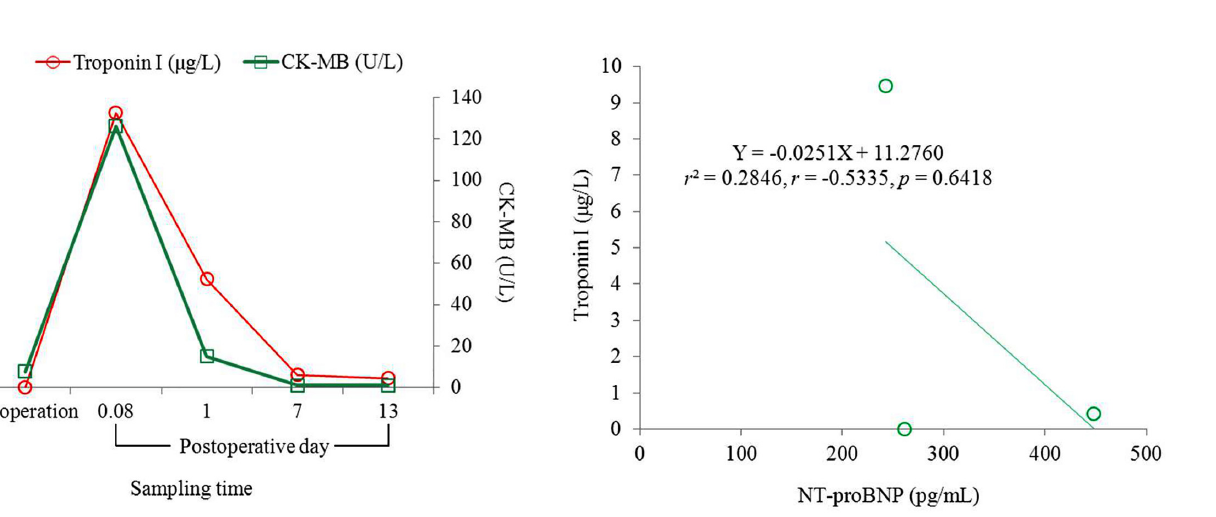
Fig. 1 - A similar changing trend of troponin I and creatine kinase isoenzyme MB. CK-MB=creatine kinase isoenzyme MB.